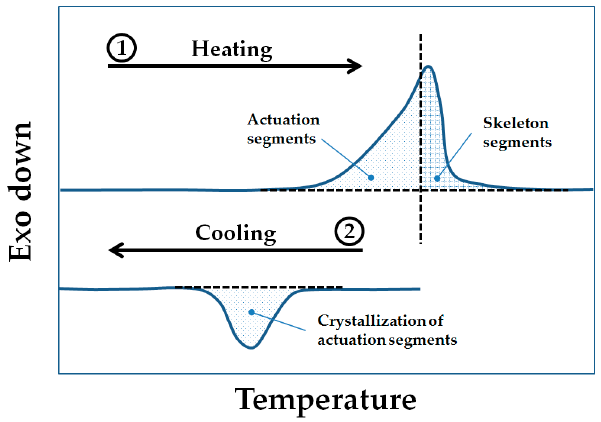
Figure 1 . Calorimetric scheme of “separation” of actuation segments from skeleton segments of same polymer nature during heating (1) and subsequent crystallization of these actuation domains during cooling (2).